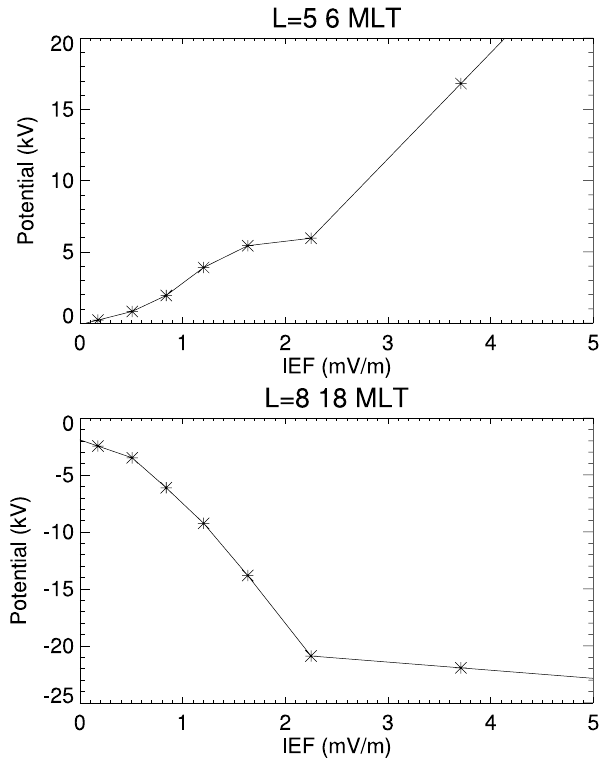
two spatial bins. The upper and lower panels show electric poten- tials at L = 5 and 06:00MLT and at L = 8 and 18:00MLT, respec-